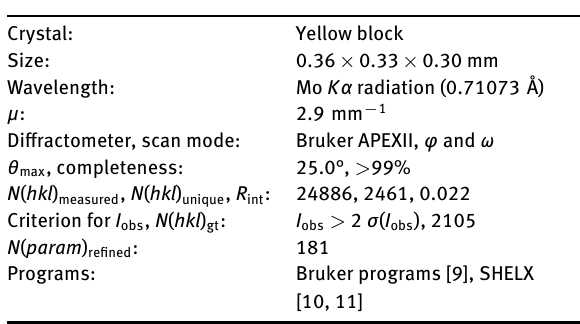
Table 1: Data collection and handling.